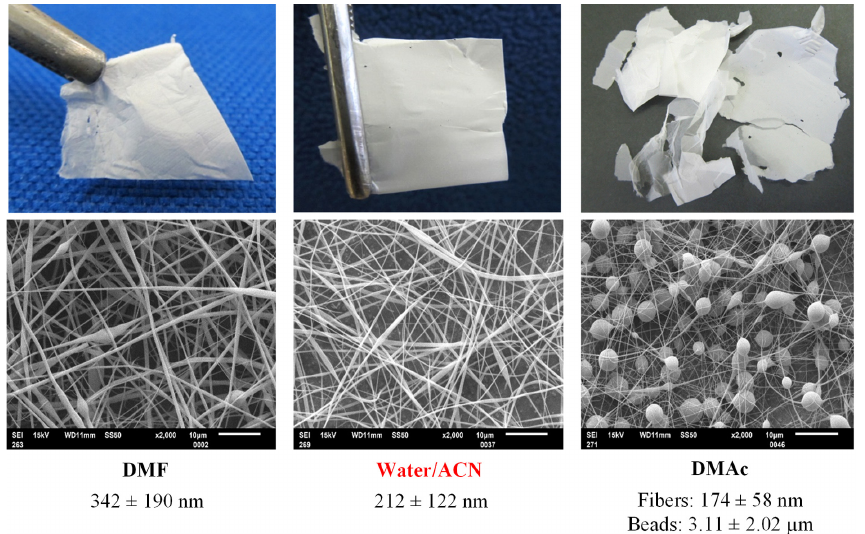
Figure 4. Photos of nanofibrous mats prepared by electrospinning, on the top, of 160% ( w/v ) solutions in DMF, in W/A, and DMAc (using 15 kV voltage, 0.1 mL/h of flow rate, and 15 cm) and, on the bottom, the associated SEM